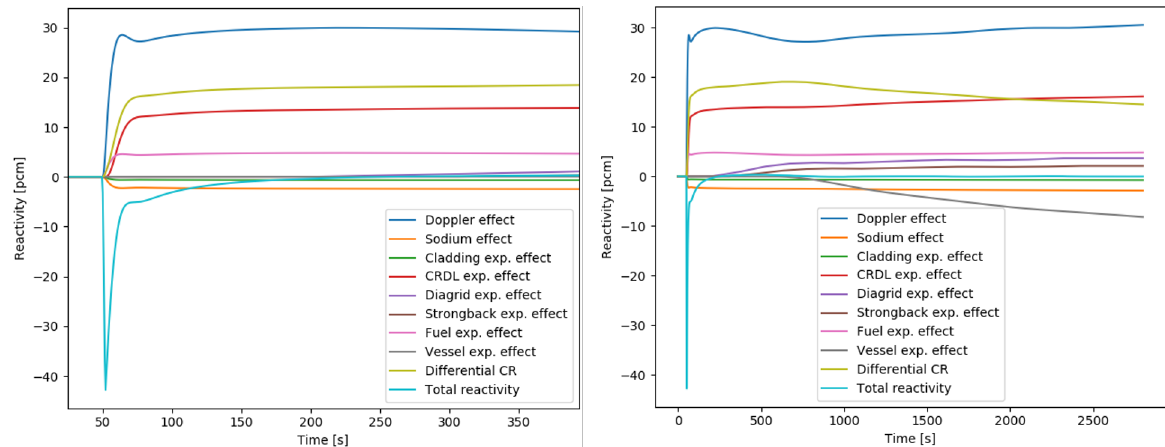
Figure 5: Reactivity components calculated by the point kinetic model during the MOCF1 transient. Left side: zoom on the beginning of the